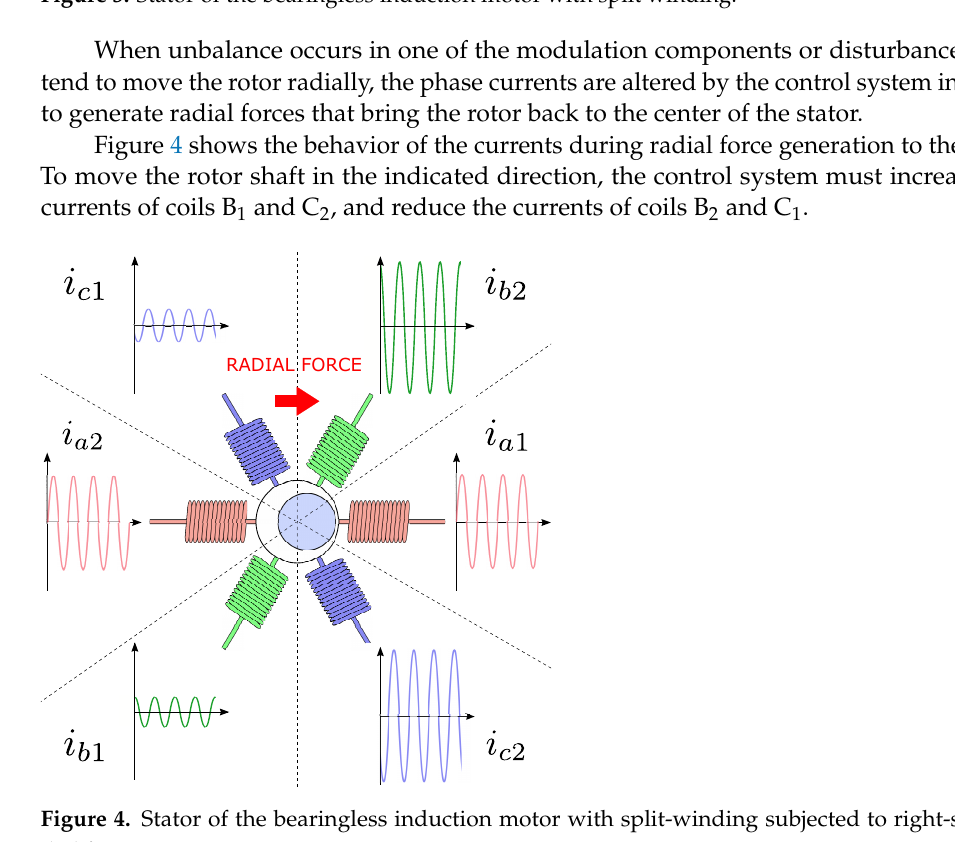
Figure 3. Stator of the bearingless induction motor with split winding.